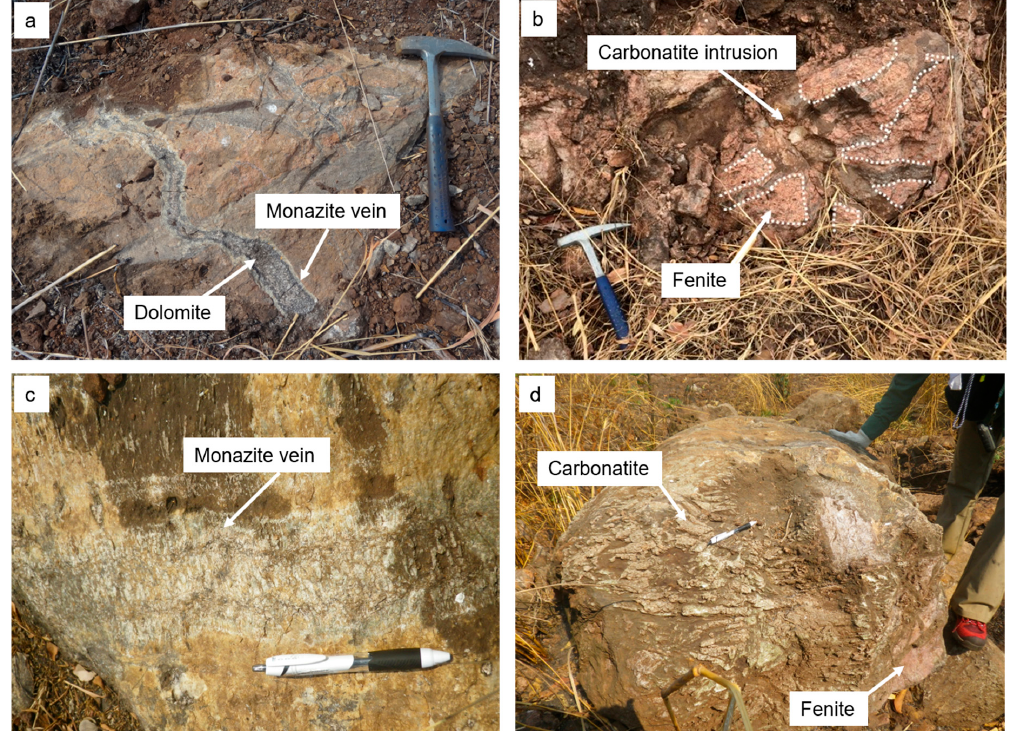
Figure 2. Field photographs of carbonatite outcrops at Kangankunde: ( a ) Zoned dolomite–monazite vein that cuts a carbonatite–fenite breccia, ( b ) carbonatite intrusion in fenite, ( c ) monazite vein in a carbonatite breccia displaying unidirectional crystallisation textures, and ( d ) bulbous breccia of carbonatite and fenite agglomerate .